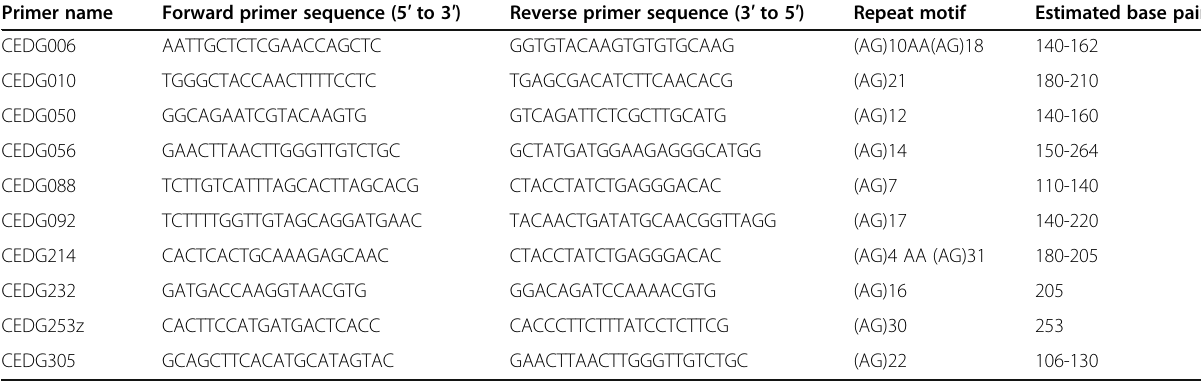
Table 1 SSR primers used and their